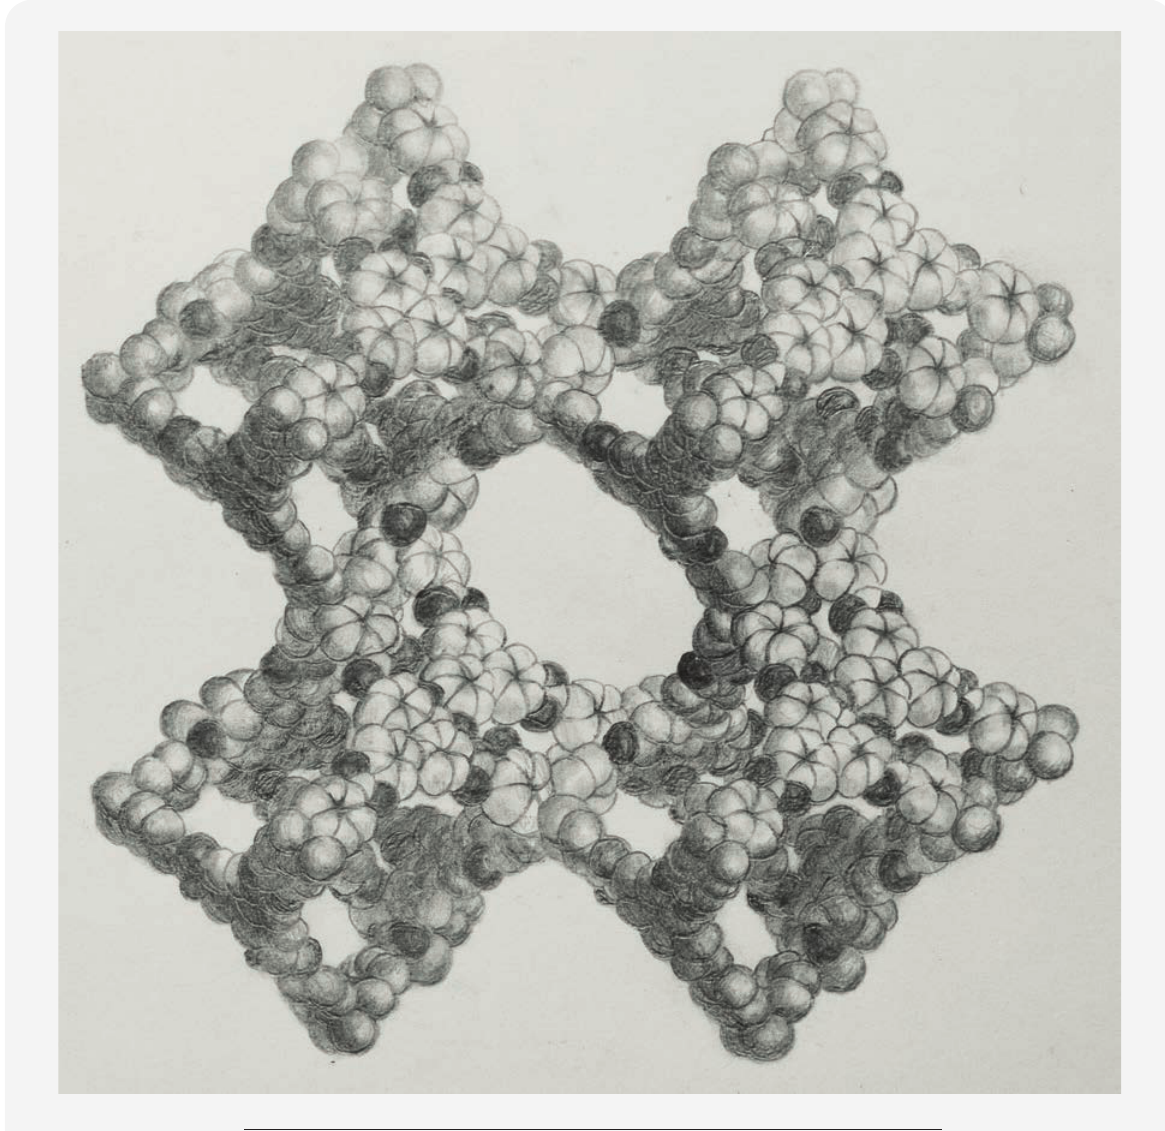
Fig. 8. COF-108 has an extended 3D structure and it is the least dense crystal known to